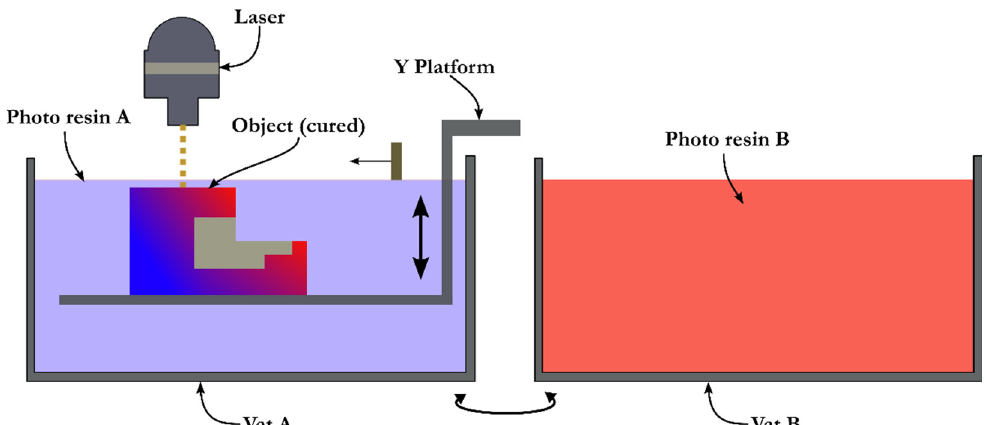
Figure 9. Process description of VAT.